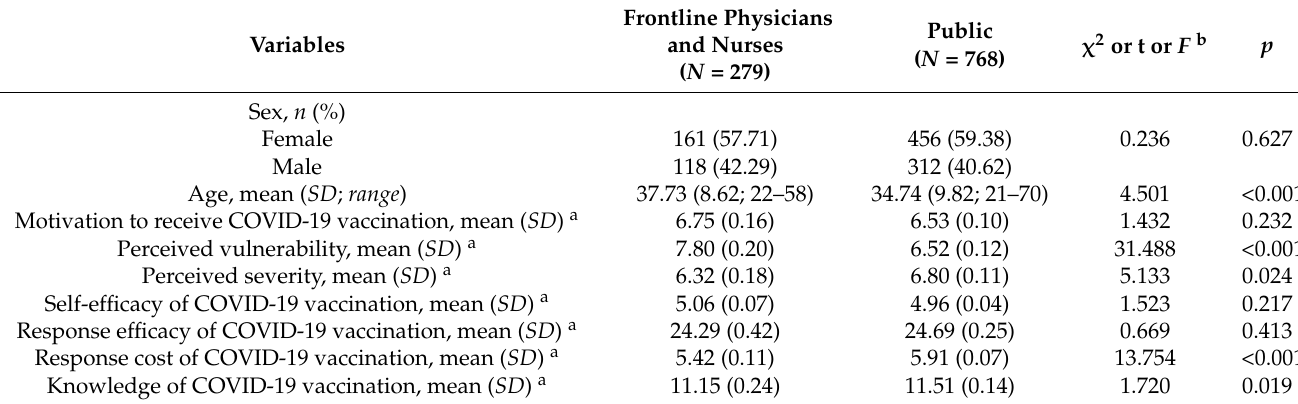
Table 2. Comparisons of Sex, Age, Motivation to Receive COVID-19 Vaccination, and Constructs of PMT as Related to COVID-19 Vaccination Between Frontline Physicians and Nurses and the